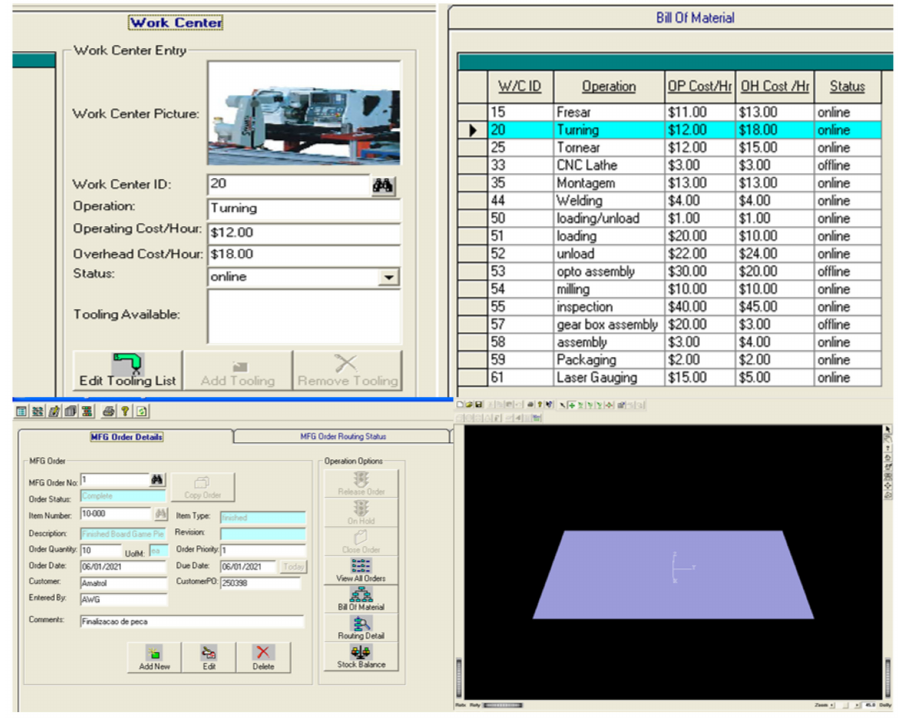
Figure 5. Definitions in ERP system: top to bottom, left to right: work centers creation, costs allocation, order releasing, and facilities layout ready to receive